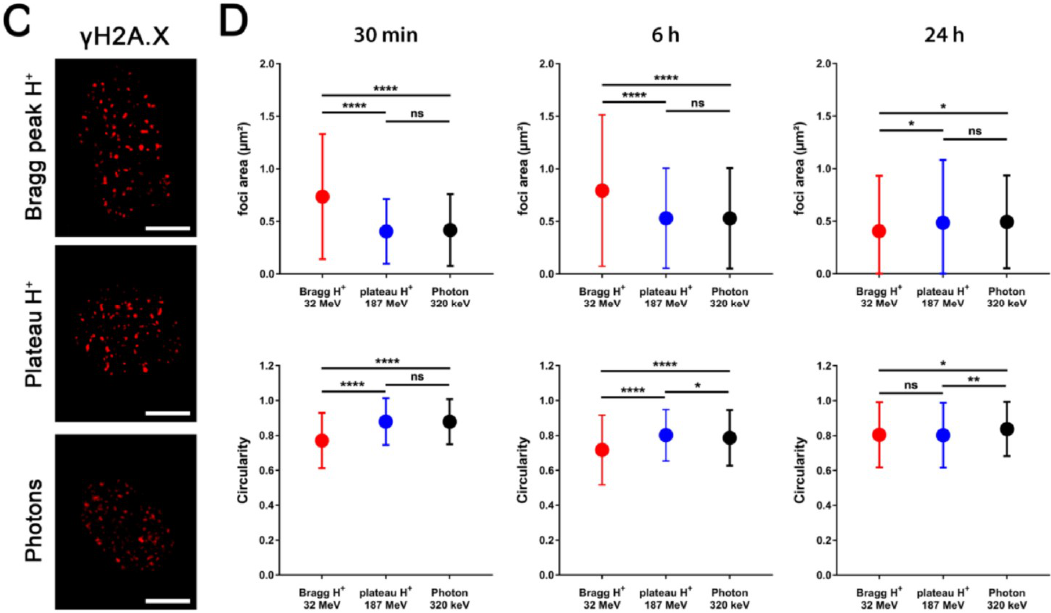
Figure 3. In-depth analysis of γH2A.X foci appearance from different types of IR. TrC1 ( A , B ) and MEFs ( C , D ) were fixed at distinct timepoints after 3 Gy of Bragg-peak proton, plateau proton, or photon irradiation, respectively. DSB sites were indirectly stained by γH2A.X immunofluorescence. ( A) and ( C) show representative high-resolution images (magnification 63×) of the 30 min timepoints, which were used for analysis of area, perimeter, and circularity of single foci (scale bar 5µm). The graph sets ( B) and ( D) display differences in foci area (upper panel) and circularity (lower panel) at three representative timepoints (30 min, 6 h, and 24 h) after different types of irradiation. Data represent mean values of at least 1000 foci/foci clusters ± SD obtained from three independent experiments. *p < 0.05, **p < 0.01, ****p < 0.0001, ns = not significant; multiple t -tests.